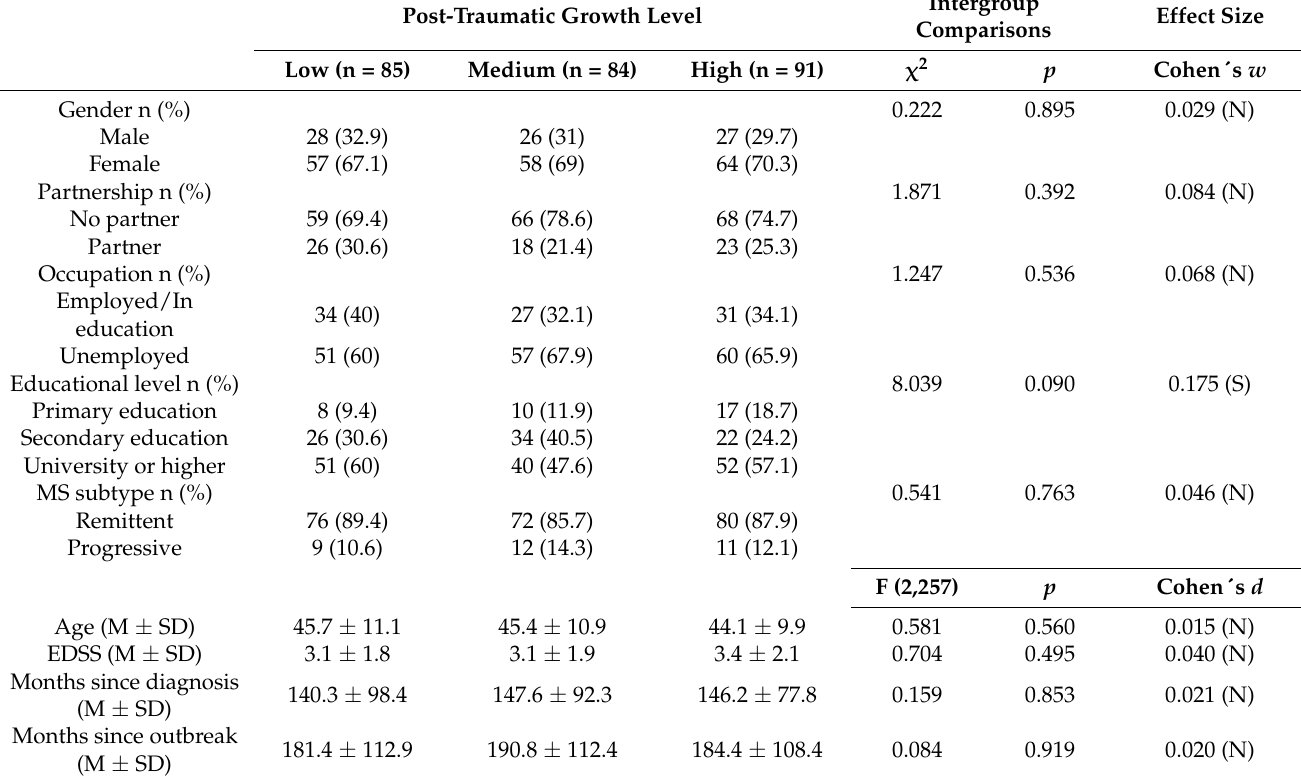
Table note: S = small effect size, N = effect